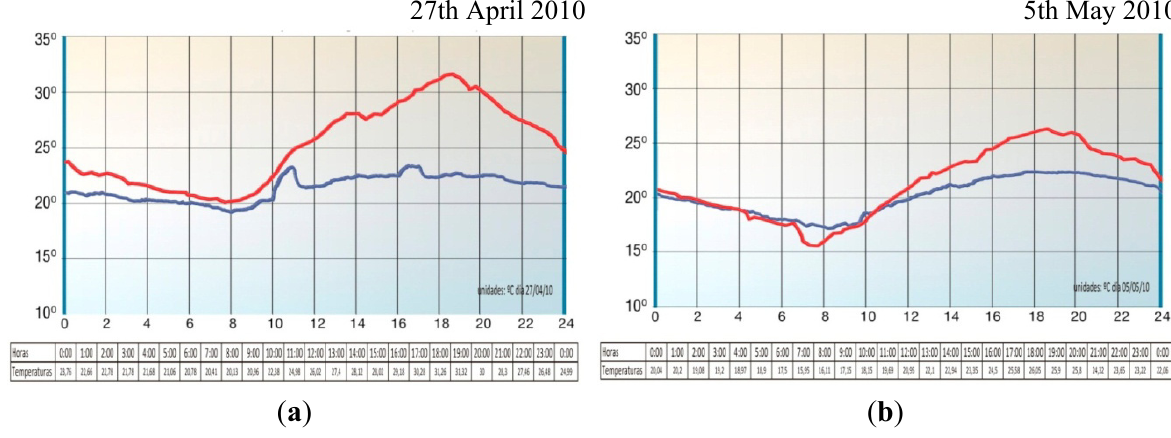
Figure 15. Red: Outside monitored temperature. Blue: Monitored temperature in the courtyard ( a ) Monitored temperatures on the 27th April 2010; ( b ) Monitored temperatures on the 5th May 2010. The courtyard acts as a heat drain on the morning and on the 27th as a heat source on the night. Monte Málaga Hotel, Málaga, Spain (Design work was completed in 2002 and the construction completed in 2005 by J. M. Rojas and J. R. Montoya,